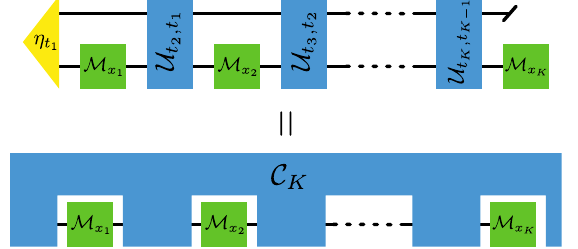
FIG. 5. Comb of a general open quantum evolution. The probabilities characterizing a quantum process can be computed via as the action of a comb C on the sequence of CP maps K f M x g that correspond to the respective measurement j